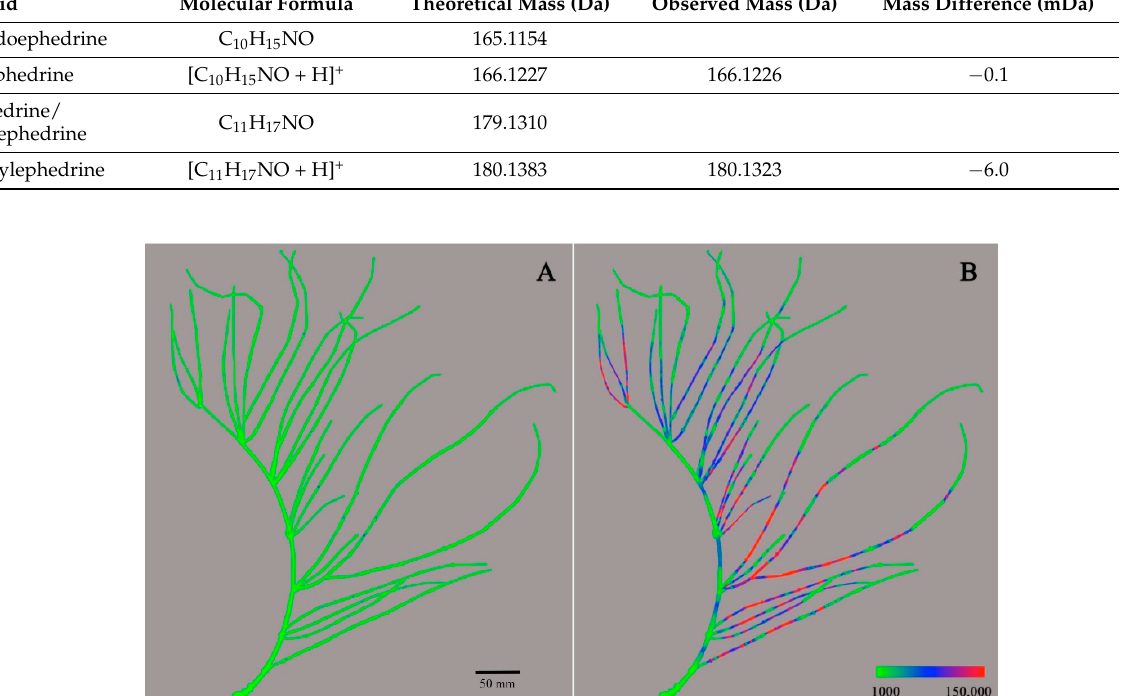
Figure 3. DART-MS images of total contents of ephedrine/pseudoephedrine ( m / z 166) on the outer surface ( A ) and an inner surface ( B ) of ephedra aerial part. The color range is from 1000 to 150,000 ion intensity.